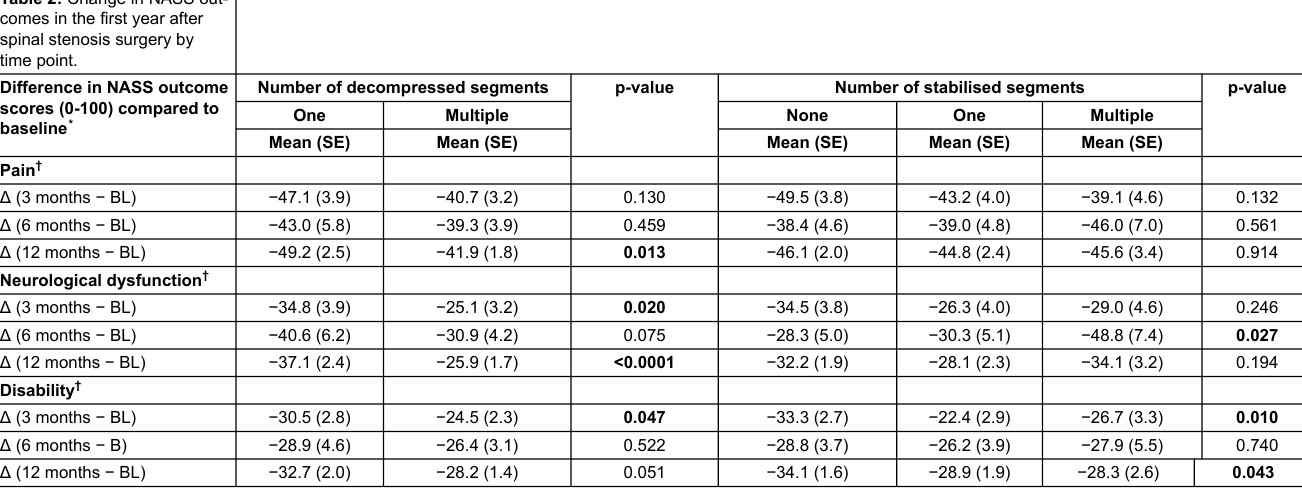
Table 2: Change in NASS outcomes in the first year after spinal stenosis surgery by time point.